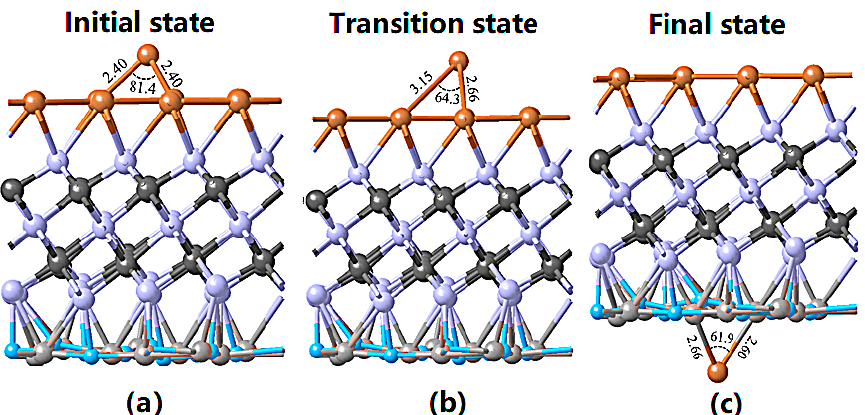
Figure 2. Cu diffusion through the Cu/Cr 2 C/TiN stack in its ( a ) initial state, ( b ) transition state, and ( c ) final state. The units of bond length and bond angle are angstrom (Å) and degree, respectively.